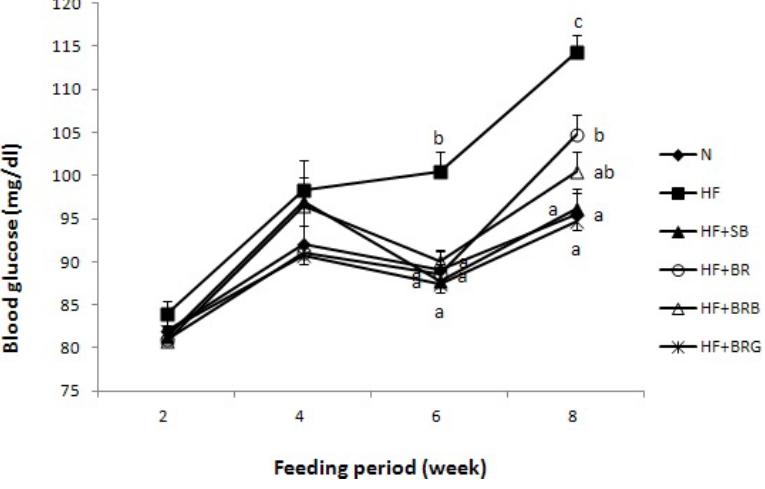
Figure 1. Effect of diet supplementation of rice fermented paste on the blood glucose level in high fat-fed mice. Means not sharing a common superscript are significantly different at p < 0.05 ( n = 8). NC, normal control AIN-76 diet; HF, high fat diet; HF + SB, high fat diet + soybean fermented paste; HF + BR, high fat diet + brown rice fermented paste; HF + BRB, high fat diet + brown rice and rice bran fermented paste; HF + BRG, high fat diet + brown rice and red ginseng marc fermented paste.